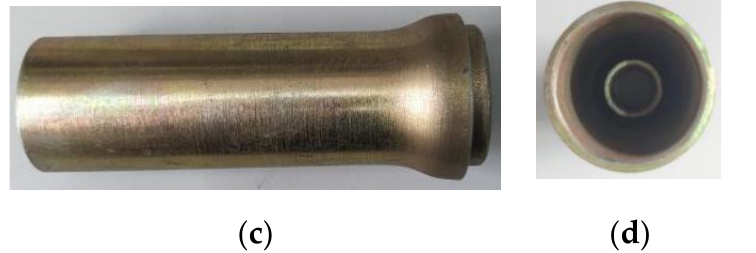
Figure 1. Constant resistance anti-impact device. ( a ) Flared thin-walled round tube, ( b ) special- shaped nut, ( c ) constant resistance anti-impact device combination chart, ( d ) top view of constant resistance anti-impact device.